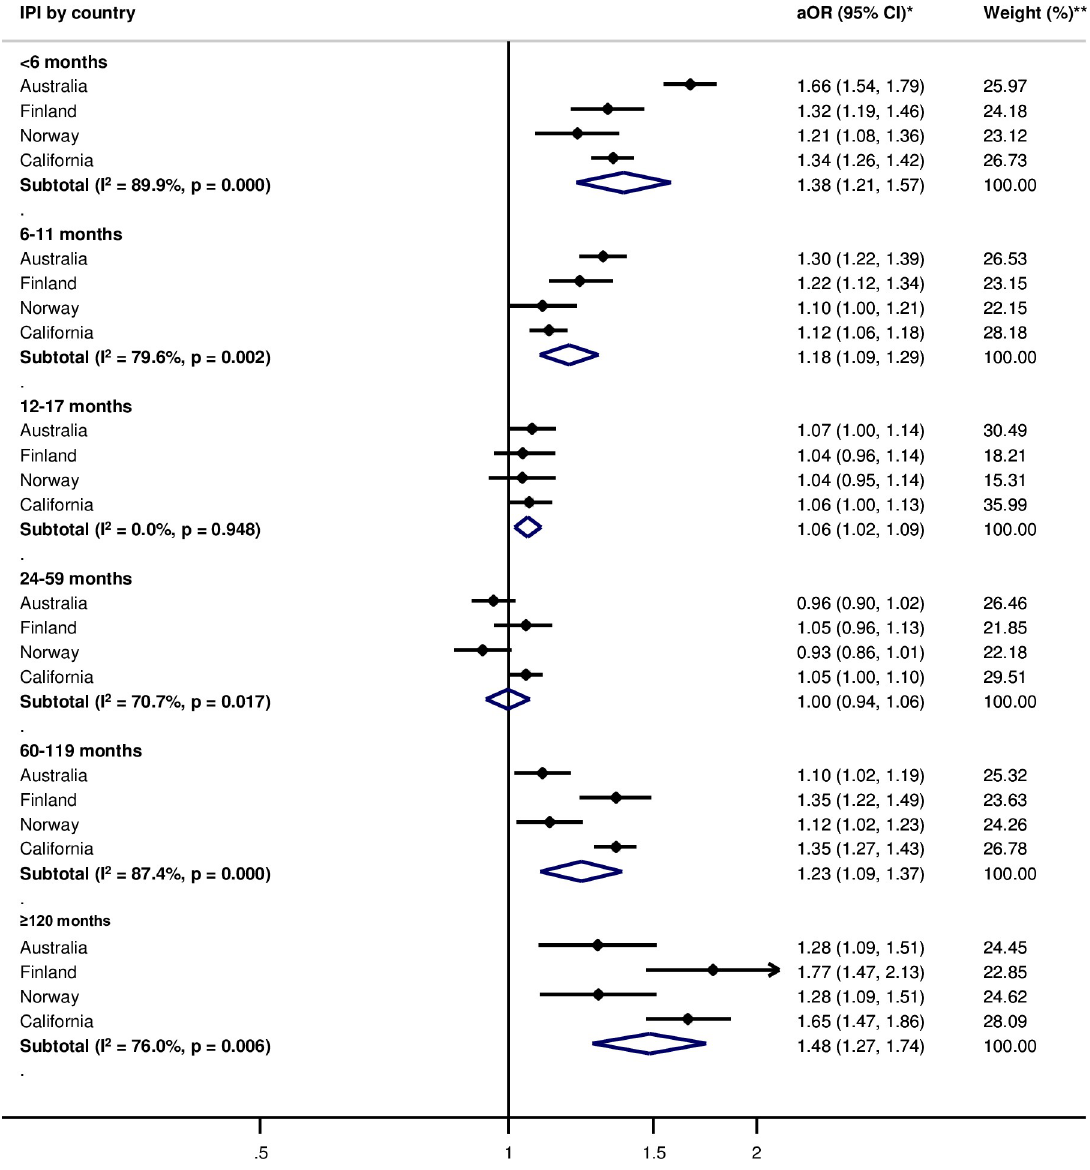
Fig 2. Adjusted odds ratios for within-women analysis for the association between interpregnancy interval and spontaneous preterm birth as compared to 18–23 months of interpregnancy interval by country. IPI—interpregnancy interval. � Adjusted Odds ratios (aOR) and corresponding 95% confidence intervals, adjusted for maternal age, parity, and birth year; the reference IPI category is 18–23 months. �� Weights are derived from